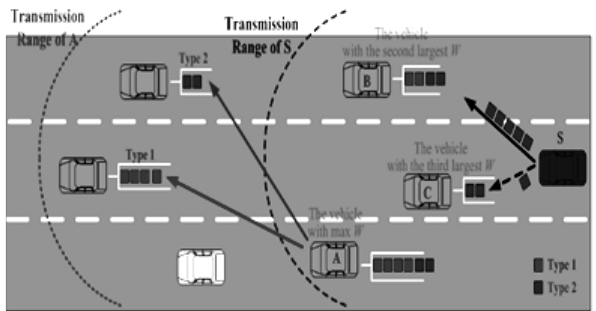
Fig. 3. DiffServ scenario in the FAB scheme.